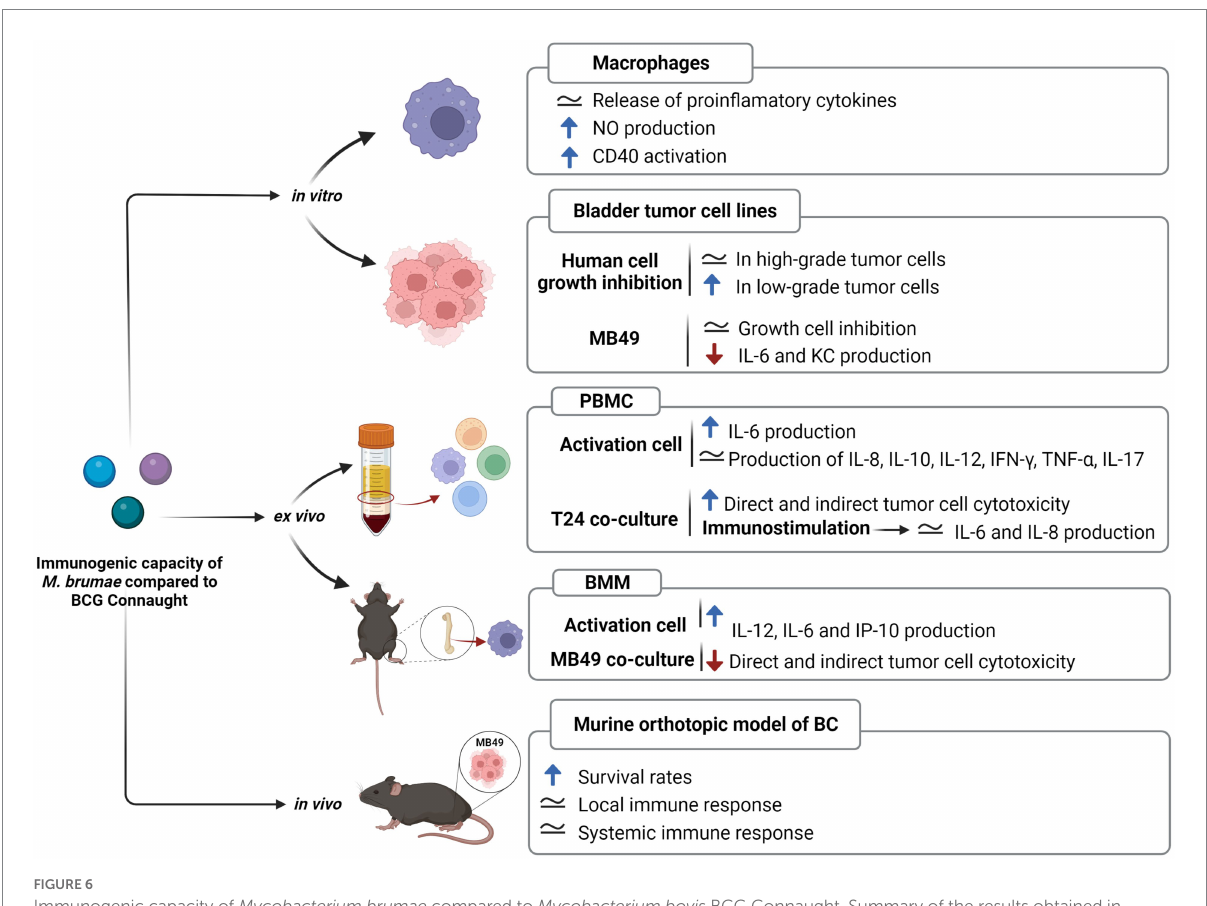
FIGURE 6 Immunogenic capacity of Mycobacterium brumae compared to Mycobacterium bovis BCG Connaught. Summary of the results obtained in studies treating with both mycobacteria J774 macrophages cell line (Noguera-Ortega et al., 2016b), bladder cancer cell lines (Noguera-Ortega et al., 2016a), human peripheral mononuclear cells (Noguera-Ortega et al., 2016b), and murine bone-marrow macrophages (unpublished); and after treating intravesically with each mycobacteria bladder cancer tumor-bearing mice (Noguera-Ortega et al., 2016a,b, 2018). Blue rising arrow indicates higher than M . bovis BCG Connaught, red falling arrow indicates lower than M . bovis BCG Connaught and the equals symbol indicates similar to M . bovis BCG